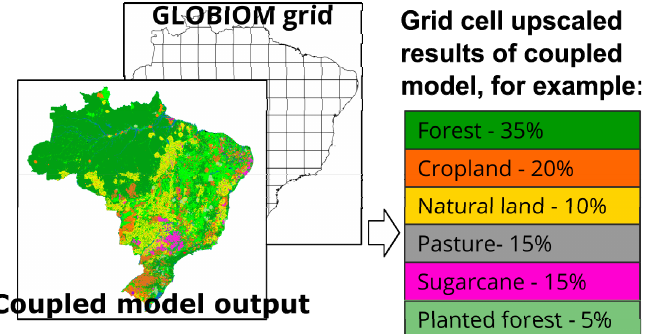
Figure 3. Upscaling of the results of PLUC in the coupled model to GLOBIOM-Brazil resolution, implying a change from nominal (categorical) to scalar (fractional) data as shown on the right-hand side. Note that the image of the output map contains the non-harmonized classes; therefore, the colors of the grid cells do not correspond to the LU class colors used throughout this paper.